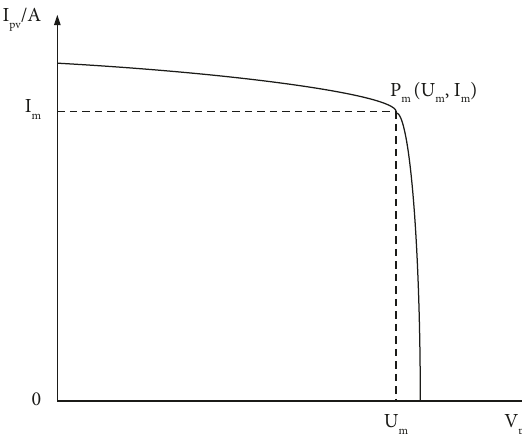
Figure 4: Principle of adaptive cancellation technology.